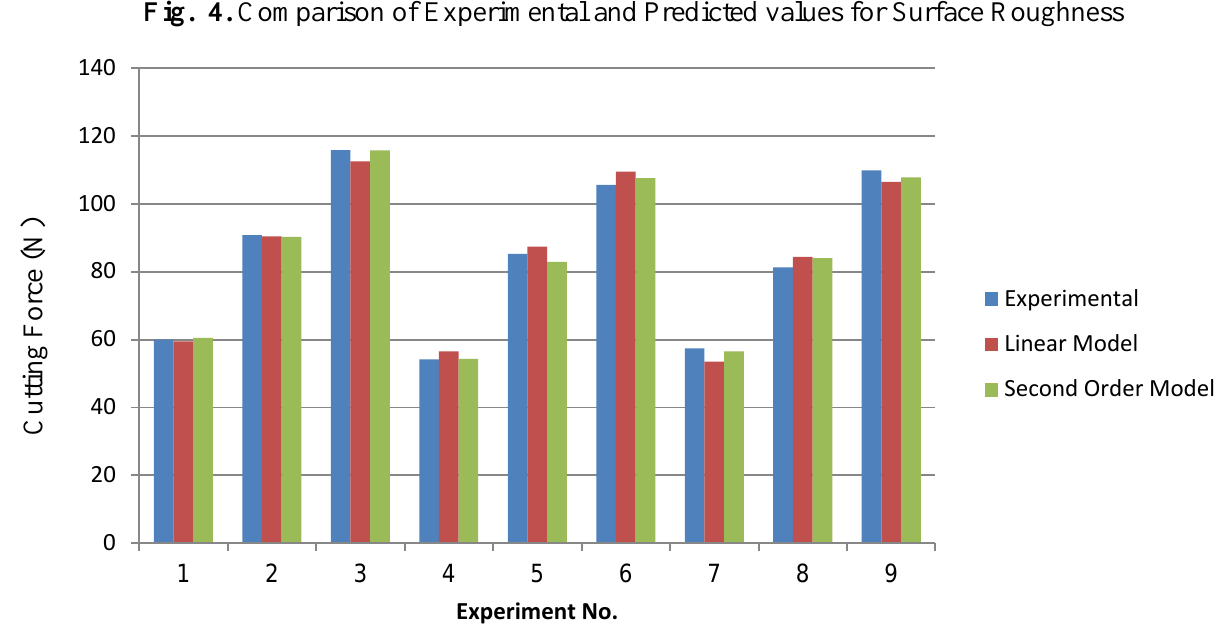
Fig. 5. Comparison of Experimental and Predicted values for Cutting